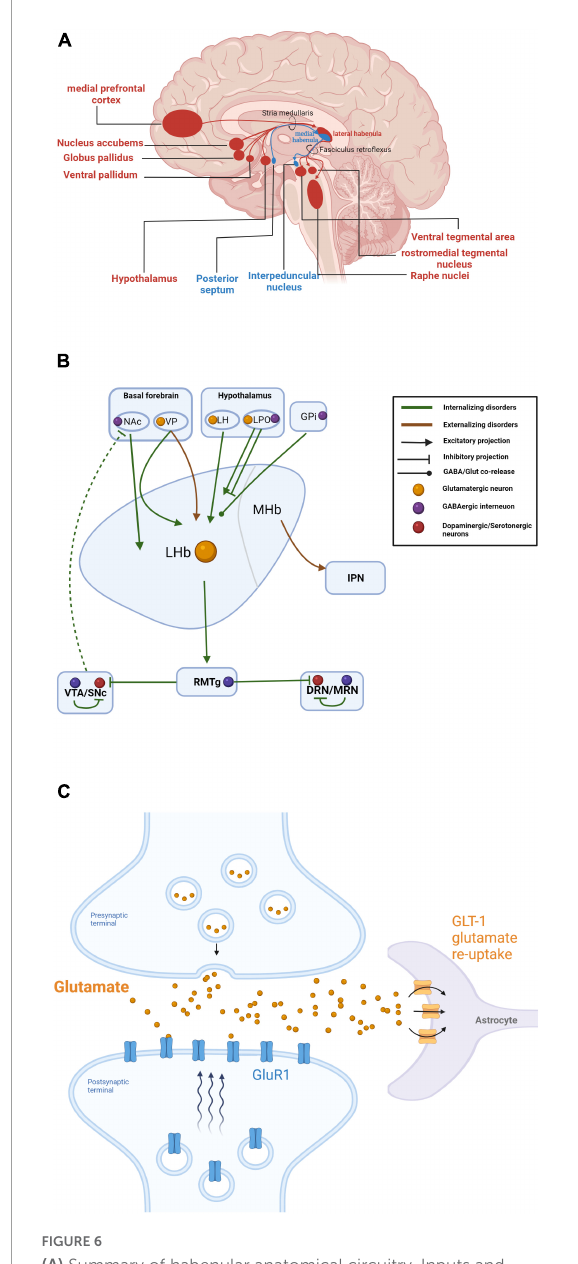
FIGURE6 (A) Summary of habenular anatomical circuitry. Inputs and outputs to and from the lateral and medial habenula are shown in red and blue, respectively. (B) Summary of habenular circuits related to different dimensions of psychiatric disorders. Internalizing disorders (such as major depressive disorders and anxiety disorders) are preferentially related to upstream projections to the Hb from the nucleus accumbens (NAc), ventral pallidum (VP), lateral hypothalamus (LH), and lateral preoptic area (LPO), and downstream projections to the rostromedial tegmental nucleus (RMTg), ventral tegmental area (VTA)/substantia nigra pars compacta (SNc), and dorsal raphe nucleus (DRN)/medial raphe nucleus (MRN). Externalizing disorders are exclusively related to the ventral pallidum (VP) and interpeduncular nucleus (IPN). (C) Mechanism for GLT-1 regulation of extracellular glial glutamatergic transmission and LHb neuron bursting. Created with